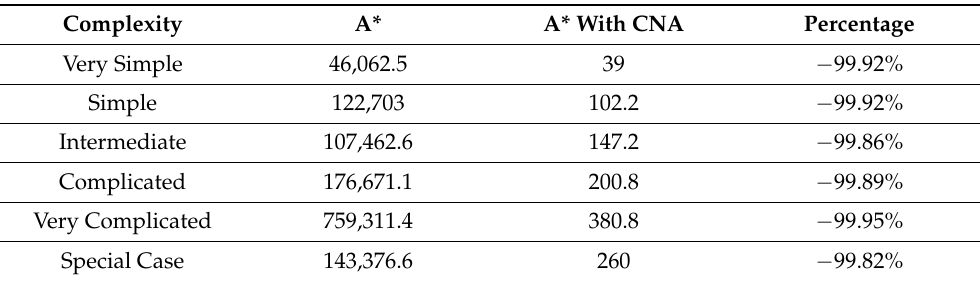
Table 4. Experimental results.